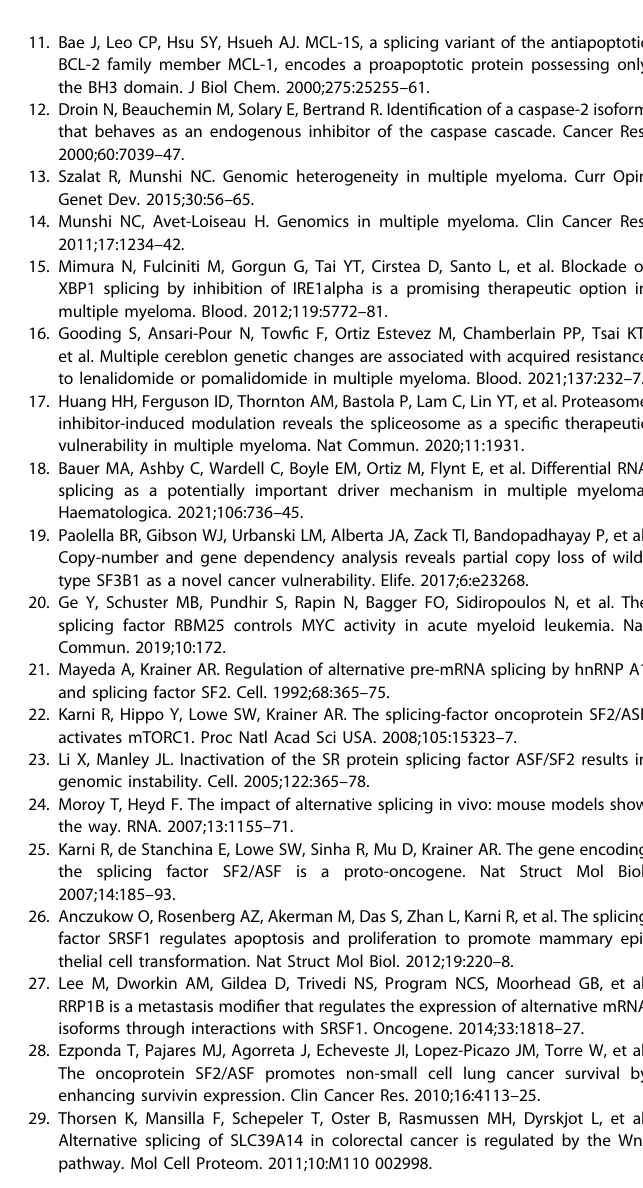
Fig. 4 Analysis of splicing events regulated by SRSF1 modulation in MM cells. A Volcano plot showing inclusion level (PSI) change ( x -axis) and false discovery rate (FDR) ( y axis) between SRSF1 overexpressing and control samples in MM cell lines. Color-coded points on the right side shows spliced events that are more utilized in SRSF1 overexpressing cells (rMATS adjusted p < 0.05, Δ PSI > 0.1) while the converse (adjusted p < 0.05, Δ PSI > − 0.1) holds in the left side. Gray denotes splicing events that are not signi fi cantly different (rMATS adjusted p > 0.05 or − 0.1 < Δ PSI < 0.1) between SRSF1 overexpressing and control samples. Five splicing event types (MXE, ES, RI, A3, and A5) are shown with different colors (red, blue, orange, purple, and green, respectively). B Upset plot showing the number of AS events after SRSF1 overexpression. The horizontal bars at the bottom left represent the total number of events induced by each mutant type (black bars on the left). The vertical bars above indicate the number of events shared between mutant experiments. The color coding of splicing types is as in panel H. Shared events between mutant types are indicated with the connected black points and lines below the vertical bar chart. C The functional association analysis of spliced genes obtained by building a network using the Reactome functional interaction database. Genes are clustered (red boxes) by protein-protein interaction networks provided by Reactome FI with pathways assigned by their functions (blue arrows). D Total numbers (upper panel) and percentage (bottom panel) of SRSF1 regulated AS events, by type (color codes), in overexpressed (upper two rows) and knockdown (bottom two rows) samples compared to their respective control cells. E Venn diagram showing the overlap between SRSF1 overexpression and knockdown experiments for genes with signi fi cant alternative splicing events. F Pathways enriched for common gene targets identi fi ed from SRSF1 overexpression and knockdown experiments are shown in Fig. 2E. G Δ PSI ( x -axis) and gene expression (log2 fold change) ( y axis) change for each gene with signi fi cant splicing change after SRSF1 overexpression. H Δ PSI ( x -axis) and gene expression (log2 fold change) ( y axis) change for each gene with signi fi cant splicing change after SRSF1 knockdown. I Altered exon usage ( y axis) of WHSC1 between SRSF1 overexpressing (red line) and control (blue line) samples. The gene model is represented on the x axis. The red box shows an alternatively spliced region in SRSF1 upregulated samples. J Isoform usage fractions (mean isoform utilization on y axis) of two isoforms (shown in blue and yellow) of WHSC1 in SRSF1 overexpressing samples (left bars) and control (right